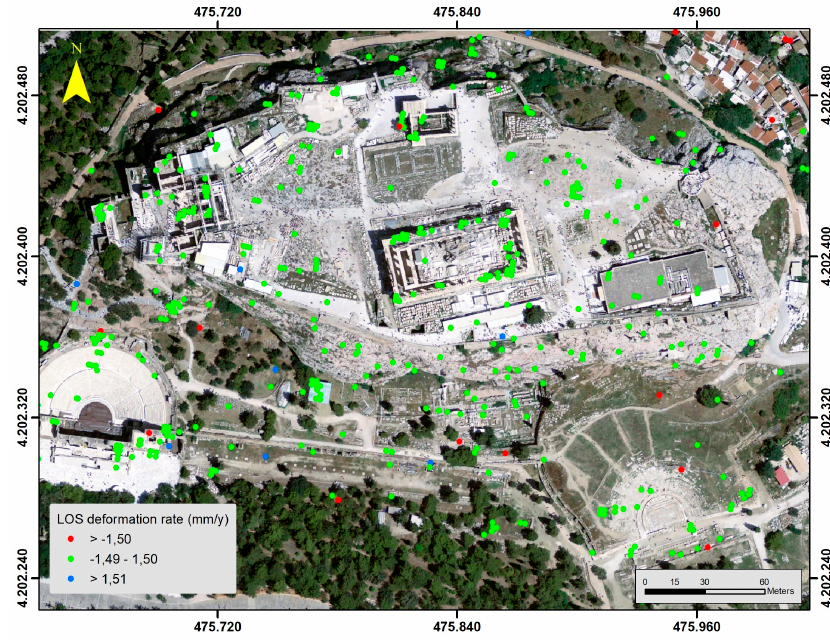
Figure 12. Surface deformation